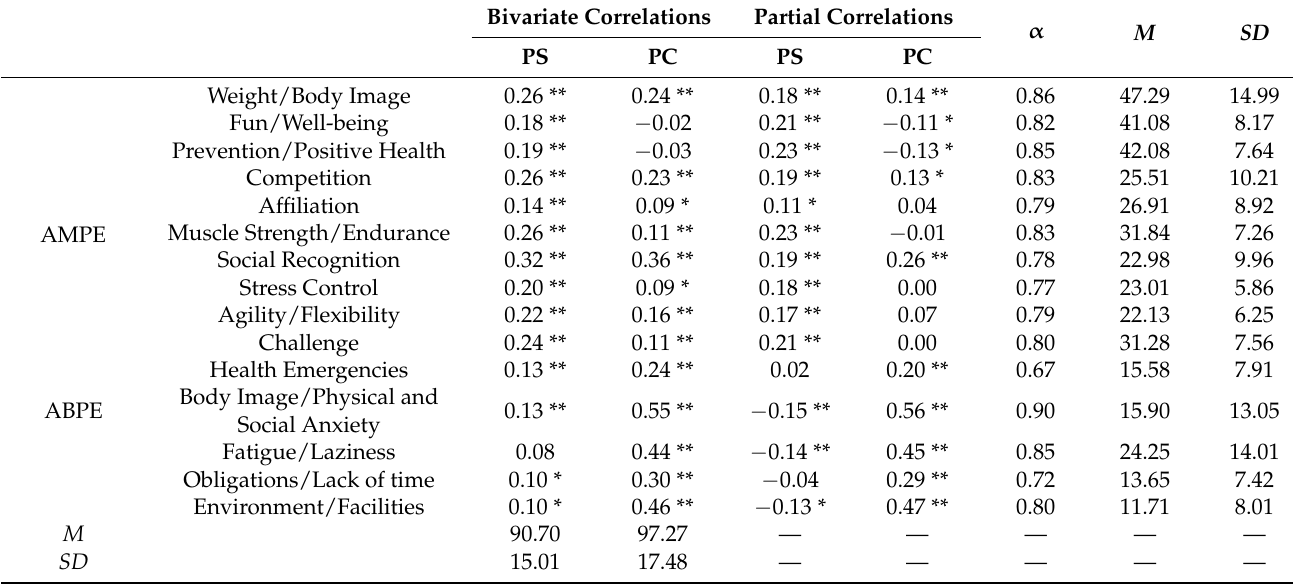
Table 1. Reliability, means, standard deviations, and bivariate and partial correlations between the perfectionism dimensions and the participation motives and barriers to